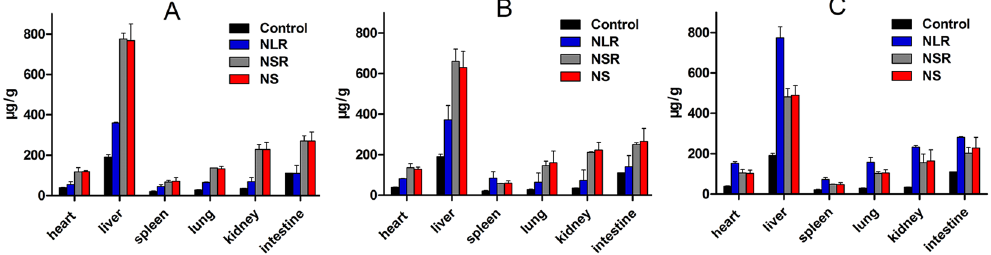
Figure 5. Biodistribution of three different MSNs after oral administration. Si content in heart, liver, spleen, lung, kidney, intestine at ( A ) 2 h, ( B ) 24 h and ( C ) 7 days post-oral.